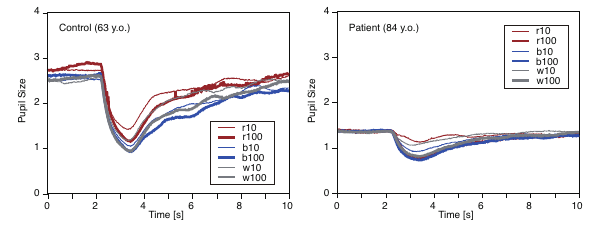
Figure 1. An example of PLRs for a control group subject and an AD patient [11, 27]